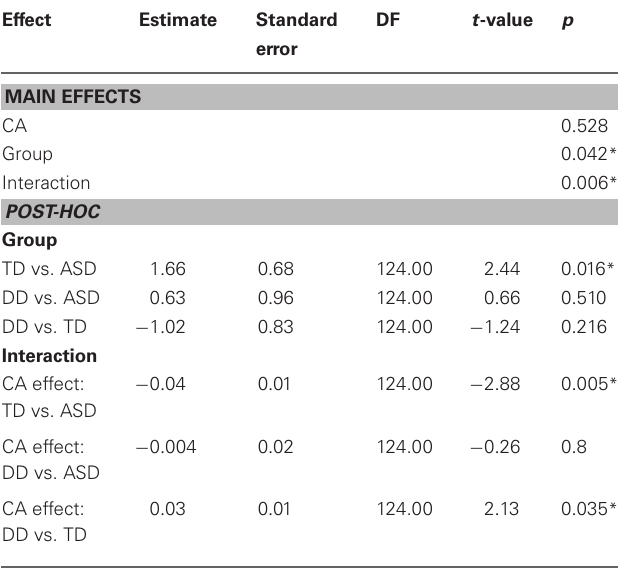
Table 3 | Grip to load force onset latency and chronological age